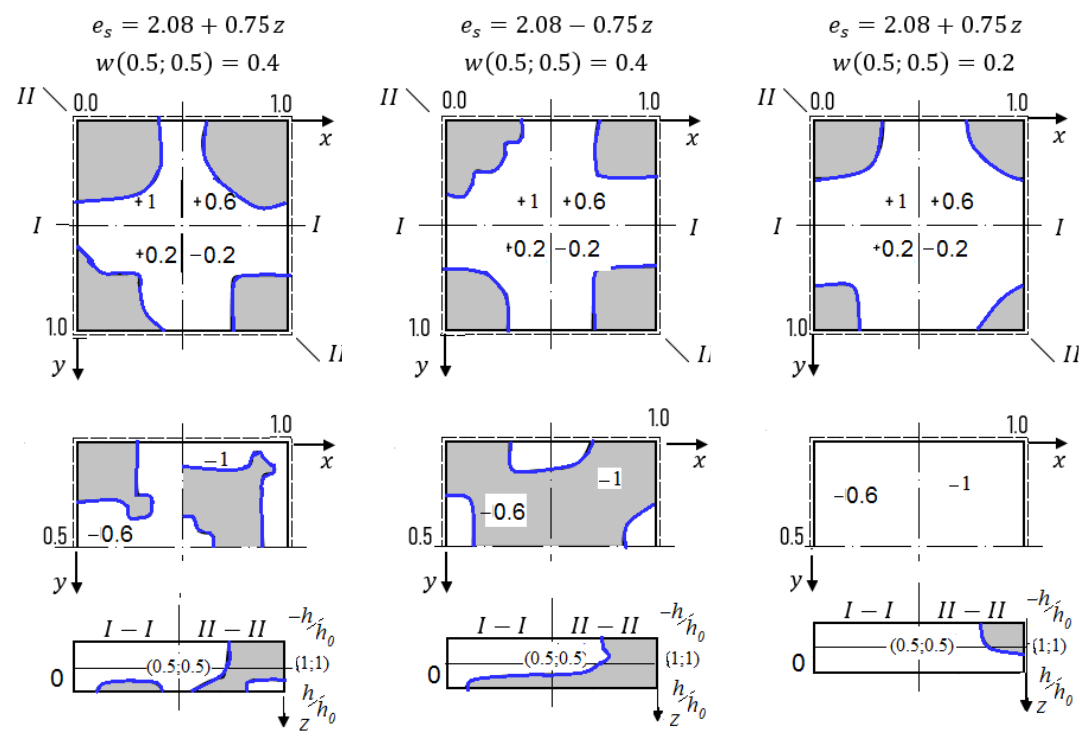
Figure 6. Views of the elastic–plastic deformation with regard to cross-section I–I and cross-section II–II along the shell thickness h = + 1; + 0.6; + 0.2; − 0.2; − 0.6; − 1 for K x = K y = 24.